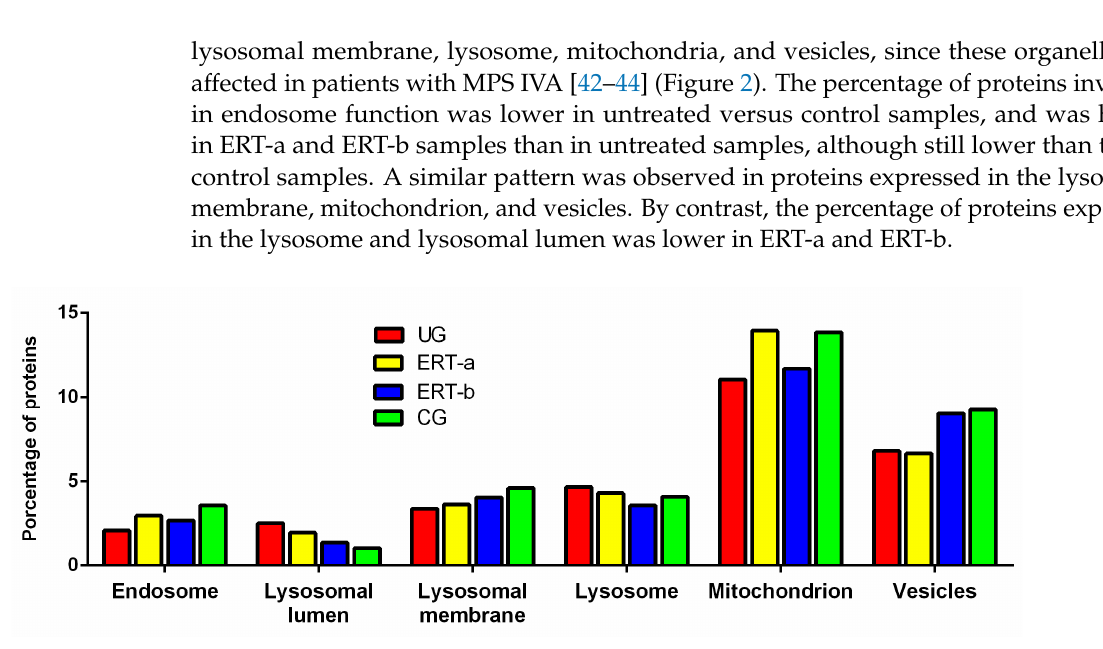
Figure 2. Functional analysis using the FunRich program. This figure shows the changes in the relative percentages of leukocyte proteins expressed in the endosome, different parts of the lysosome, the mitochondria, and the vesicles in each of the 4 groups. Abbreviations: CG: control group; ERT-a, patients sampled before enzyme infusion; ERT-b, patients sampled 24 h after enzyme infusion; UG: untreated group.